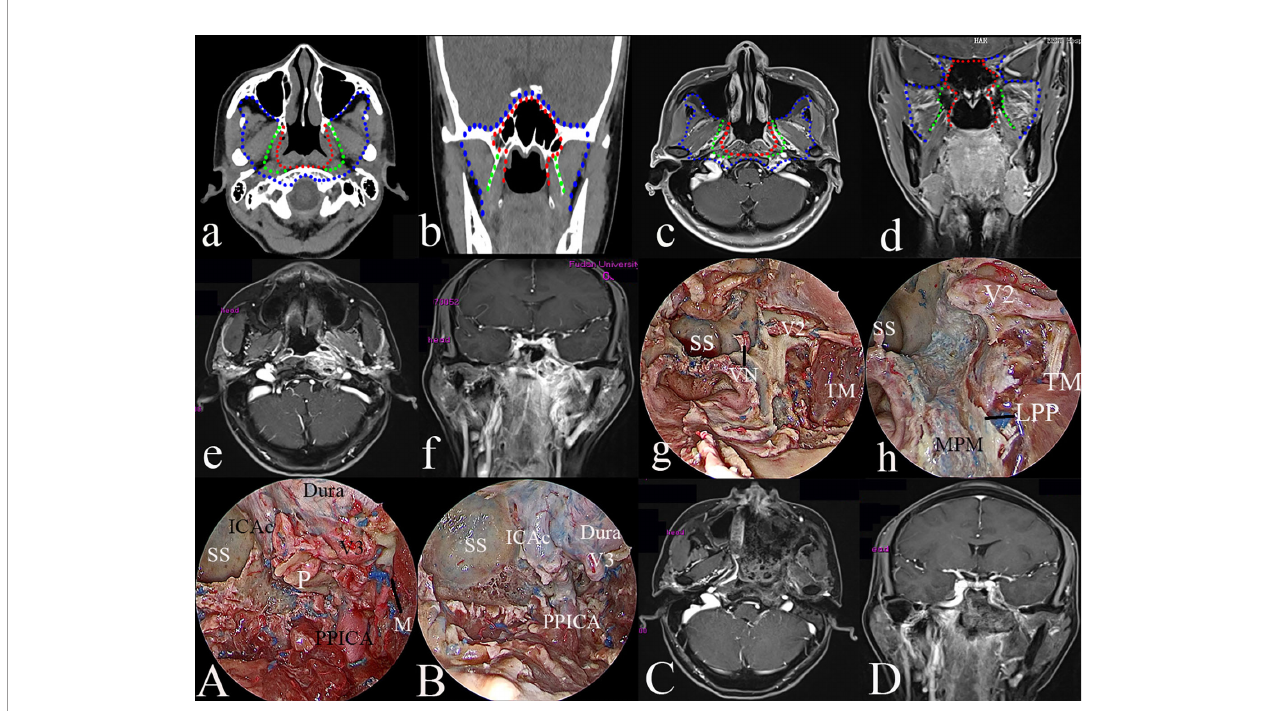
FIGURE 3 | The greatest extent of resection in Type III transnasal endoscopic nasopharyngectomy (blue dot line in a – d ), pre-operative magnetic resonance imaging (MRI) of rT3 nasopharyngeal carcinoma (NPC) (e, f) ; exposure of the key landmarks in Type III TEN (g, h, A, B) ; and post-operative MRI (C, D) . ICAc, clival internal carotid artery; LPP, the lateral pterygoid plate; MPM, medial pterygoid muscle; M, middle meningeal artery; P, petrous bone; PPICA, parapharyngeal internal carotid artery; SS, sphenoid sinus; TM, temporal muscle; VN, vidian nerve; V2, maxillary nerve; V3, mandibular